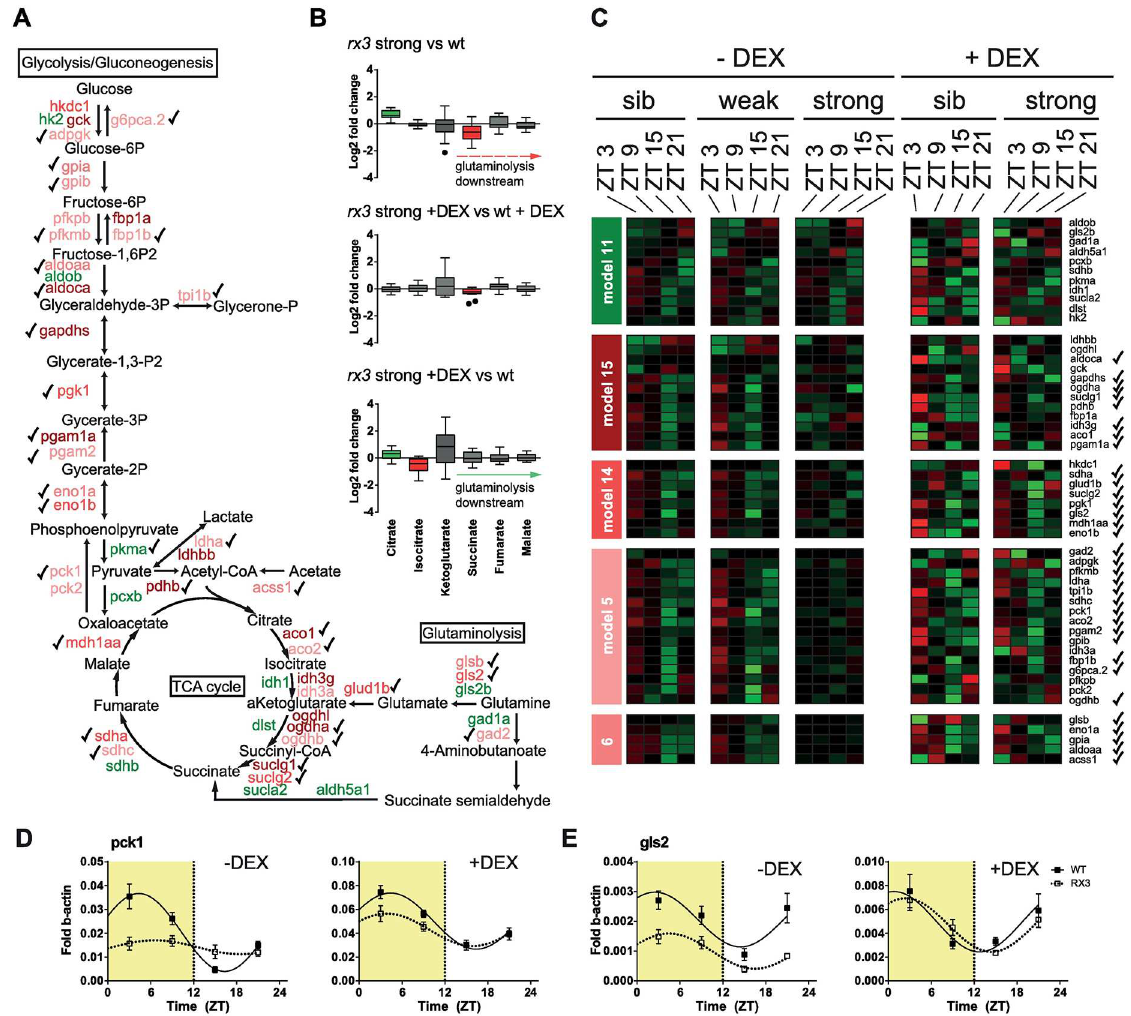
Fig 4. Glucocorticoid dependentalterationsof diurnal TCAcyclefunction. (A) Schematicdepictingglycolysis, gluconeogenesis, the TCA cycle, and glutaminolysis, indicatingthe steps wheregeneswith dysregulated temporal mRNA expression in rx3 strong mutants are involved. Gene namesare color-codedaccordingto the modelsin C. Check marks in (A) and (C) indicaterescue of dysregulated expression in rx3 strong by DEX treatment. (B) Tukey boxplotsshowingfold changesof TCA cycle metabolites when comparingthe indicated conditions. Statistically significantchangesare shownin greenfor up-regulationand in red for down- regulation.(C) Heatmapof normalizedmRNA expression levelsof the genesshownin (A), classifiedaccordingto their expression models.Red, high expression. Green, low expression. (D, E) Gene expressionlevelsof pck1 (D) and gls2 (E) mRNA levelsin 5 dpf larvae in the indicatedconditions.Linesfitted by linearregression if statistical modelsindicaterhythmicity for wild-type(continuous) and rx3 strong mutant